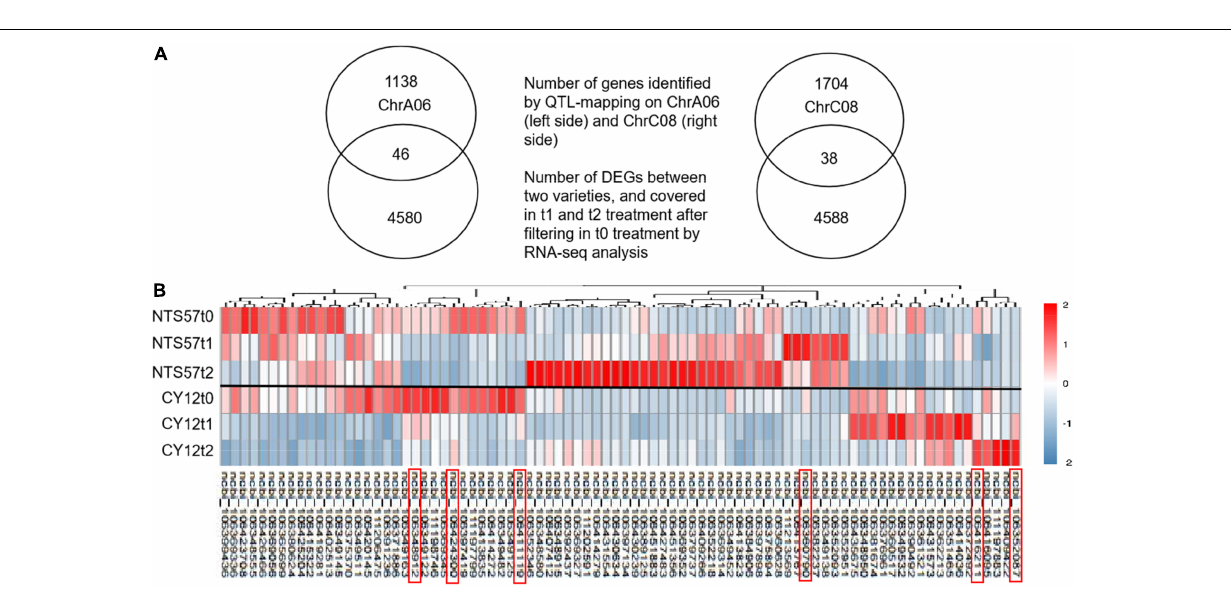
FIGURE 4 | Overlap in the DEGs identified using RNA-seq and located in QTLs. (A) The Venn diagram shows the number of genes located in QTLs related to the flowering time, the number of DEGs in the two varieties at low temperature, and the number of overlaps. (B) Heatmap showing clustered gene expression in early- and late-flowering genotypes. Different colors represent different expression levels in the late-flowering variety NTS57 and the early-flowering variety CY12 under three temperature treatments. The candidate genes selected that relate to flowering time are marked with a red